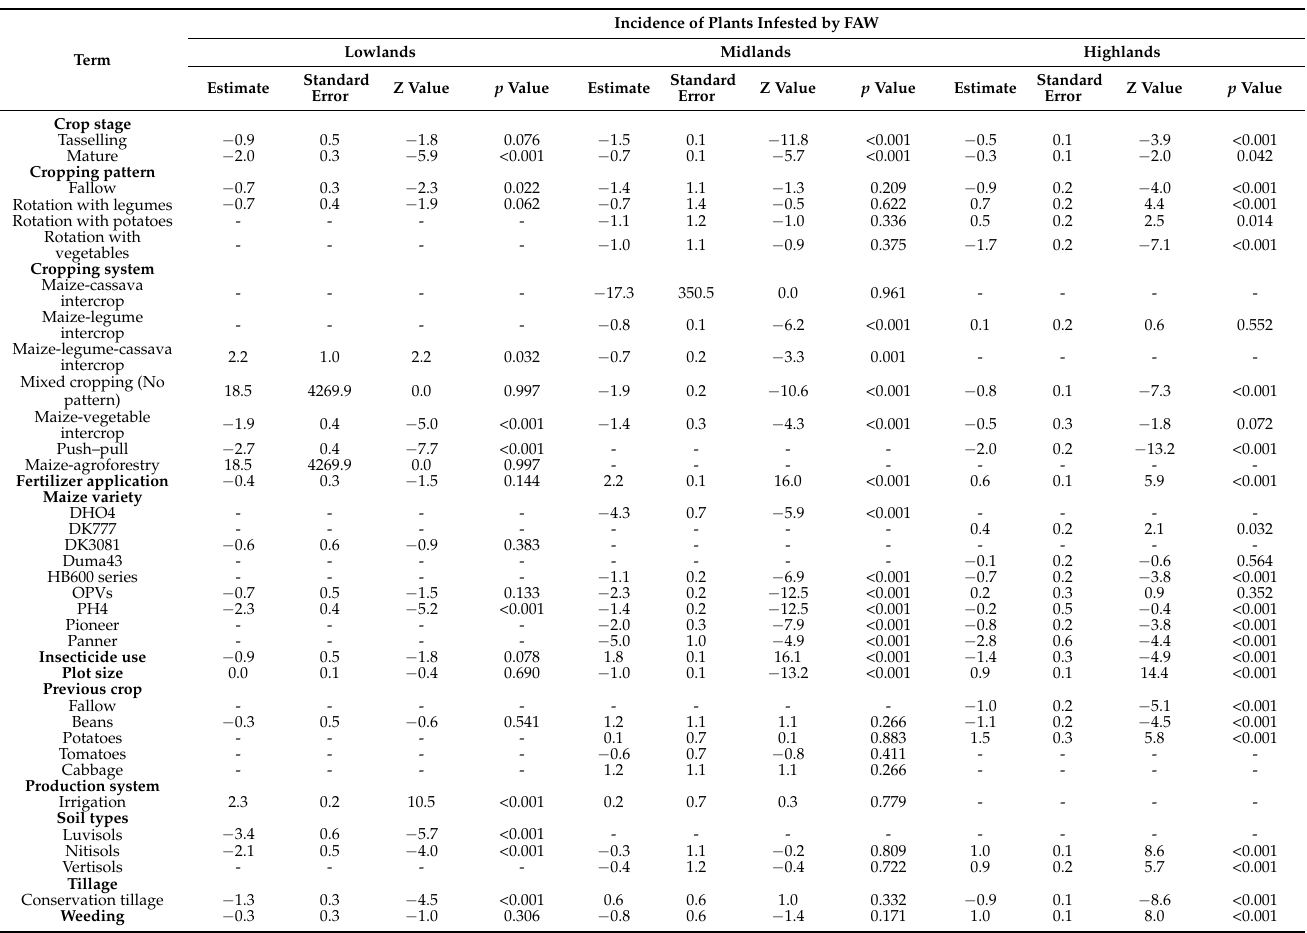
Table 4. Generalized linear models’ results for the disaggregated data on maize field characteristics and crop management practices employed by smallholder farmers interviewed during the survey for fall armyworm infestation and damage in three agro-ecological zones of Kenya in 2019/2020.